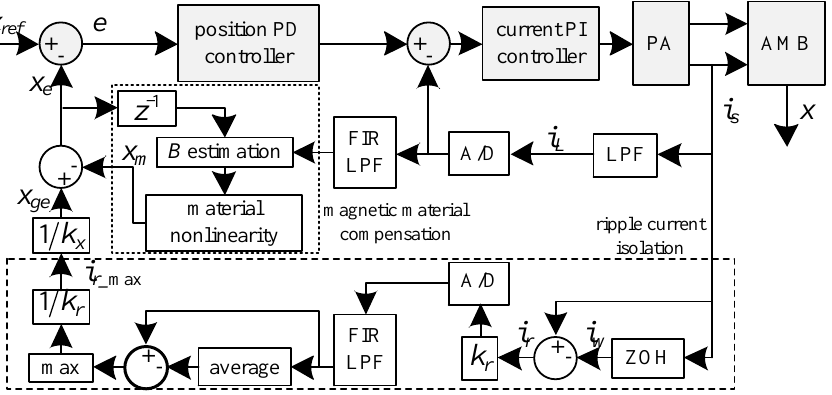
Figure 10. Configuration of the practical DCM position